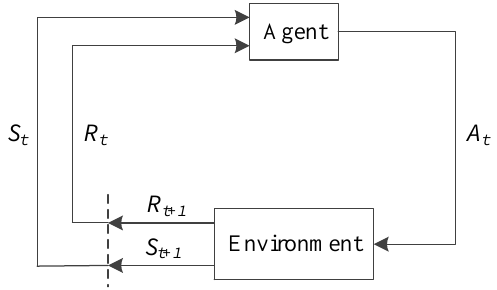
Figure 3. Reinforcement